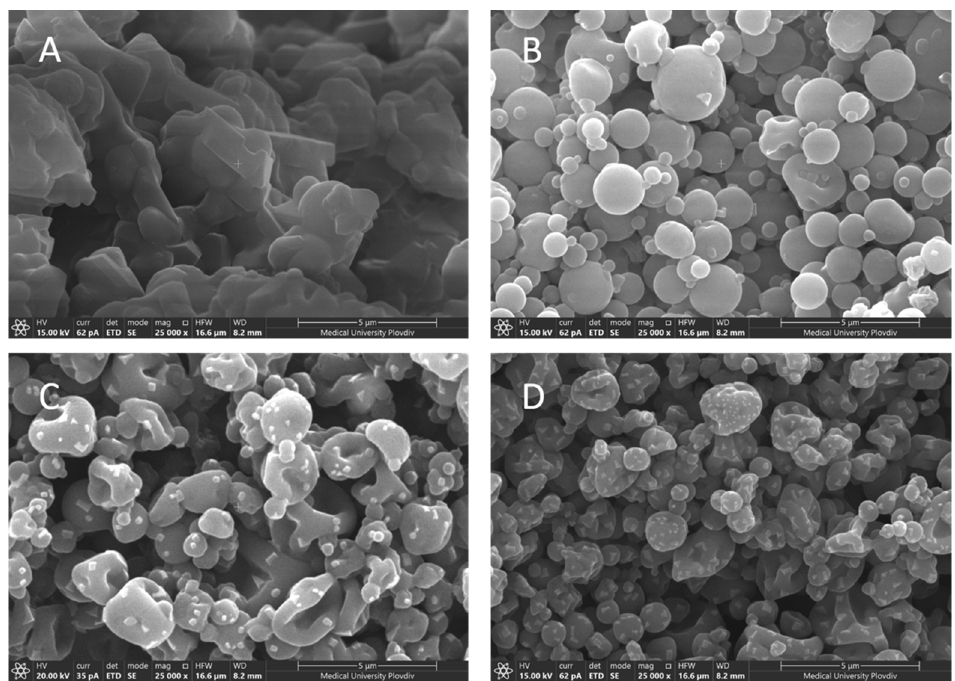
Figure 4. SEM micrographs of BZ-loaded casein nanoparticles of batches Cas2-Ca3-BZ-1 ( A ), Cas2- Ca3-BZ-2 ( B ), Cas2-Ca3-BZ-4 ( C ) and Cas2-Ca3-BZ-6 ( D ) at 25,000× magnification. Ca3-BZ-2 ( B ), Cas2-Ca3-BZ-4 ( C ) and Cas2-Ca3-BZ-6 ( D ) at 25,000 ×